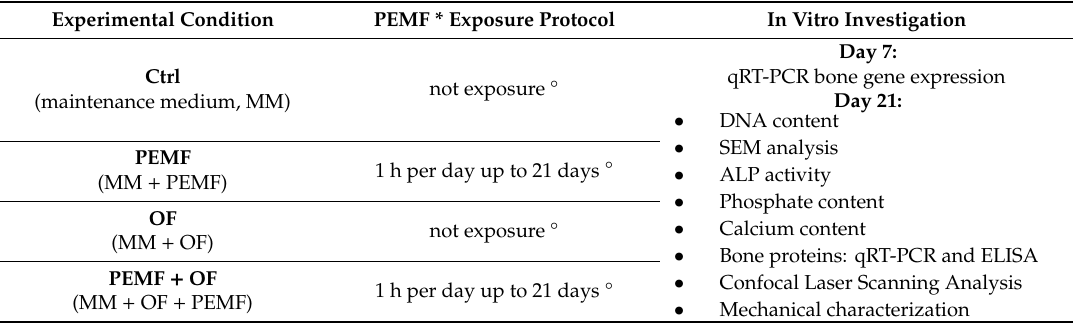
Table 1. Experimental set up to investigate the e ff ect of the daily pulsed electromagnetic field (PEMF) treatment on human SAOS-2 osteoblast-like cells seeded onto porous wool keratin sca ff old for 21 days. Experimental Condition PEMF * Exposure Protocol In Vitro